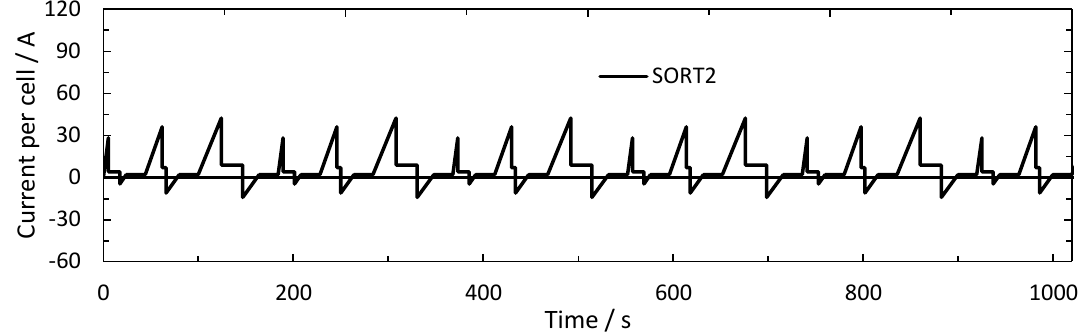
Figure 9. Current profile for repeated sequences of Standardized On-Road Test Cycle 2 (SORT2).